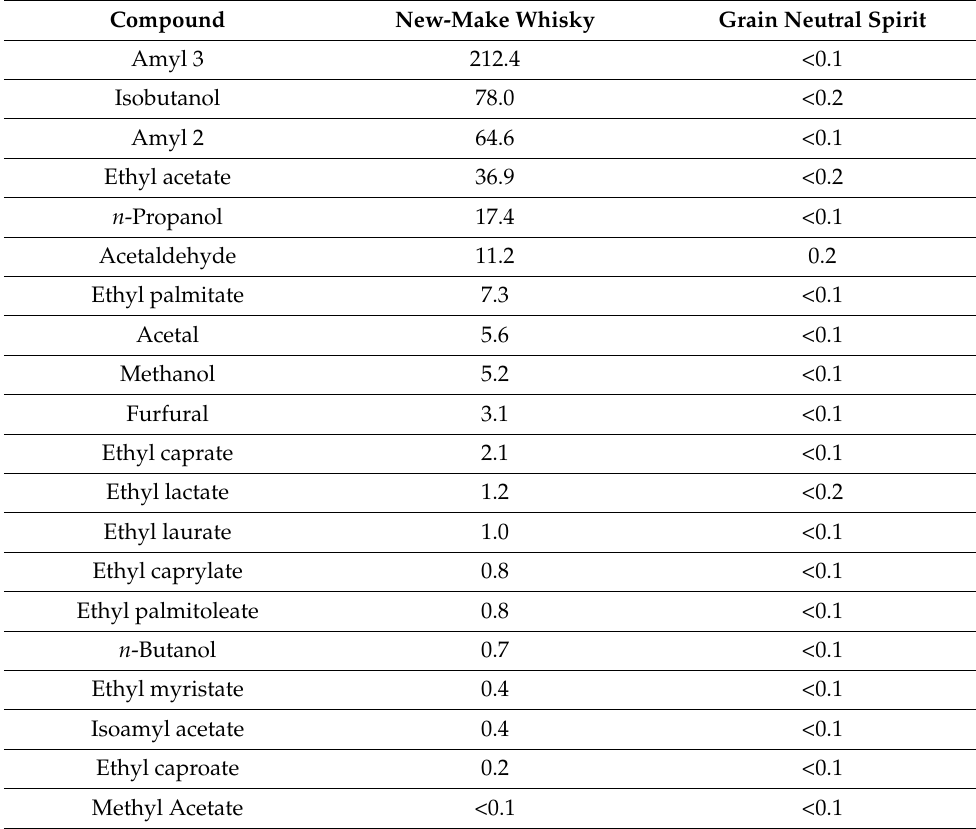
Table 3. Congener profile of new-make whisky and neutral spirits. Values are presented as grams per hectolitre of alcohol. Values with the symbol < are the test-detectable limits and indicate that the compound was not detected. Analysis courtesy of Tatlock & Thomson (by Leven, UK) on samples provided by Arbikie Distilling Ltd. (Arbroath,